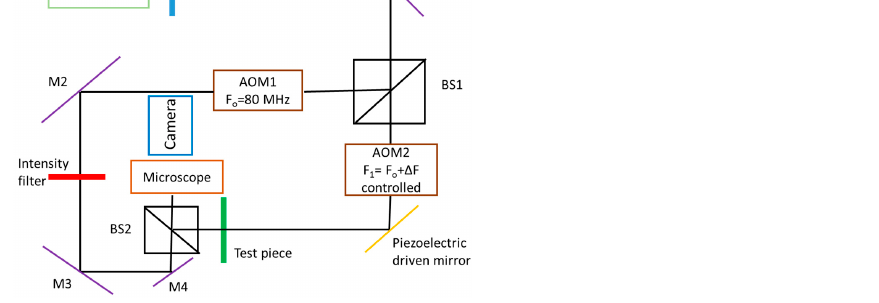
Figure 19. Typical interferometry setup for microfluidic applications, adapted from Garvey et al. [50].